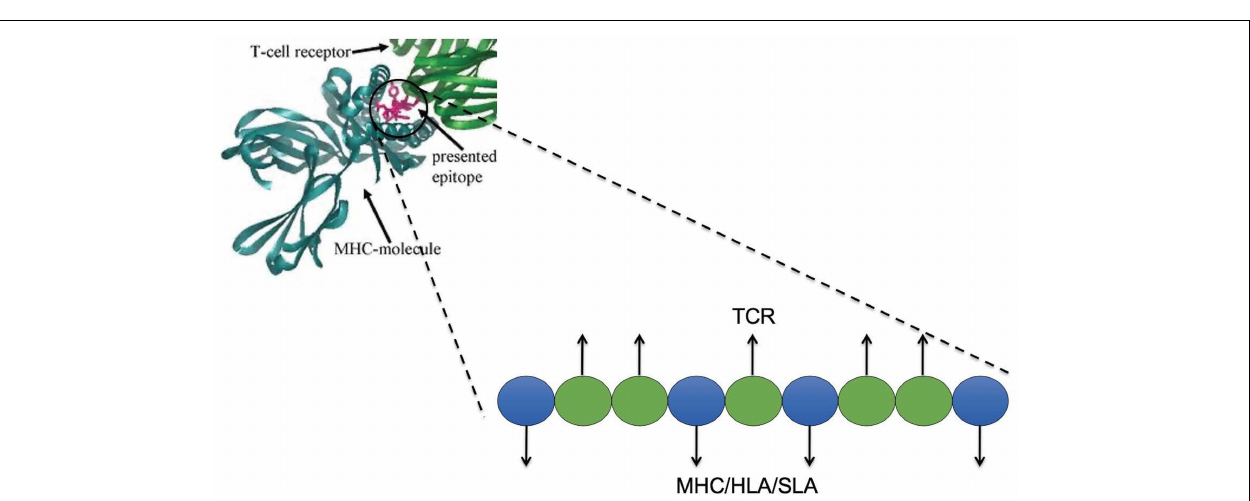
FIGURE 4 | JanusMatrix and self-like epitopes. Predicted SLA ligand with identical TCR-facing residues with the swine proteome (presented in blue) and variant SLA-binding residues (presented in green) may stimulate cross-reactive tolerizing or Treg responses, if both bind to the same SLA